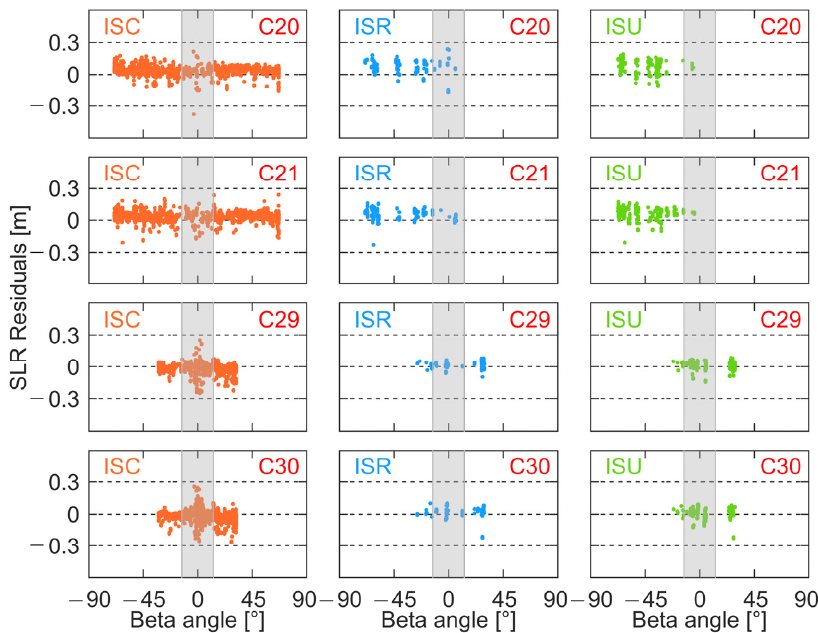
Figure 17. SLR residuals of BDS-3 satellites based on three types of iGMAS B1C/B2a orbits versus beta angle.